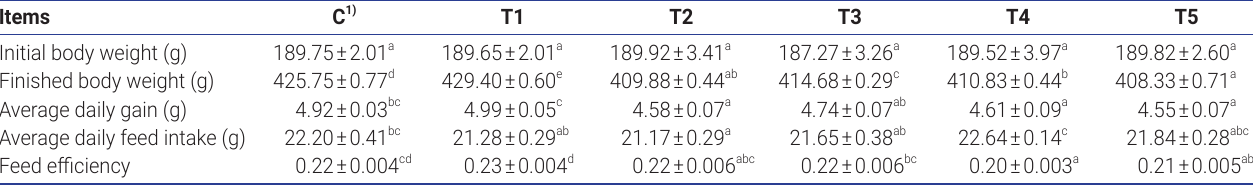
Table 1. Body weight, daily gain, daily feed intake, and feed efficiency in rats by the treatment group